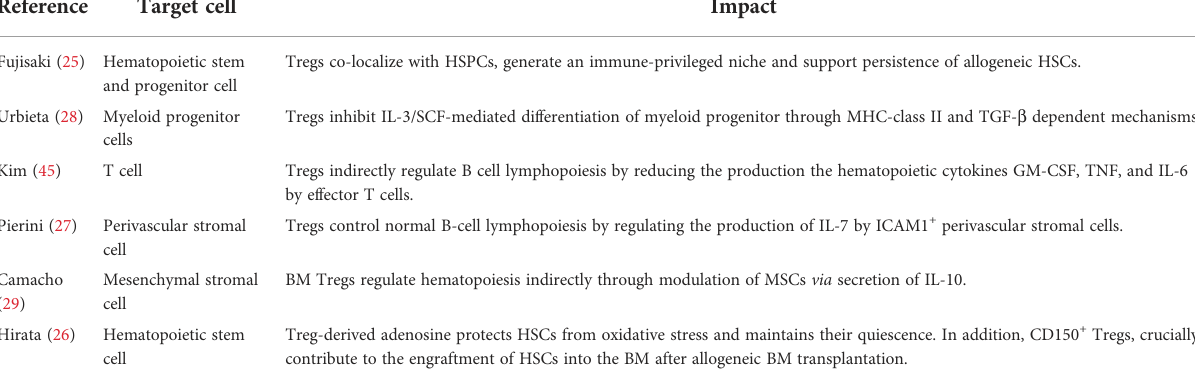
TABLE 2 Treg-mediated immunomodulatory mechanisms in the BM niche at steady state.